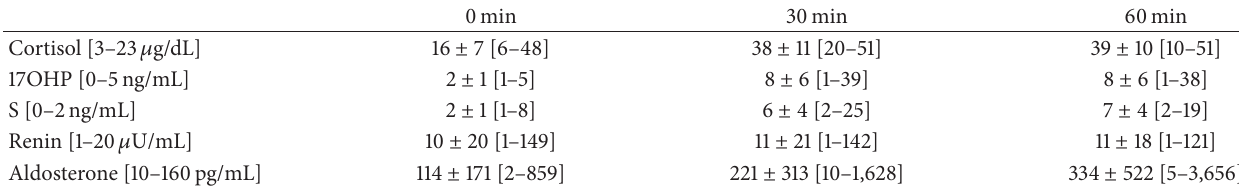
Table 1: Cosyntropin (1–24 ACTH) test (250 mg, iv at time 0).